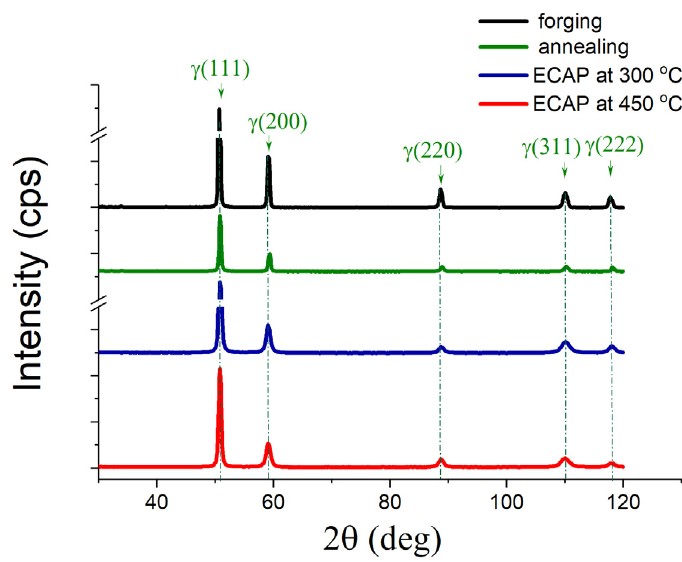
Figure 2. XRD patterns of the Fe–Mn–Pd alloy after various processing. The structure of the alloy after ECAP at 450 °C has a five times lower dislocation density compared to the alloy samples after ECAP at 300 °C, which is explained by a higher deformation temperature at the same equivalent cumulative strain. Table 2. Results of the X-ray line profile analysis of the Fe–Mn–Pd alloy after various processing. Processing